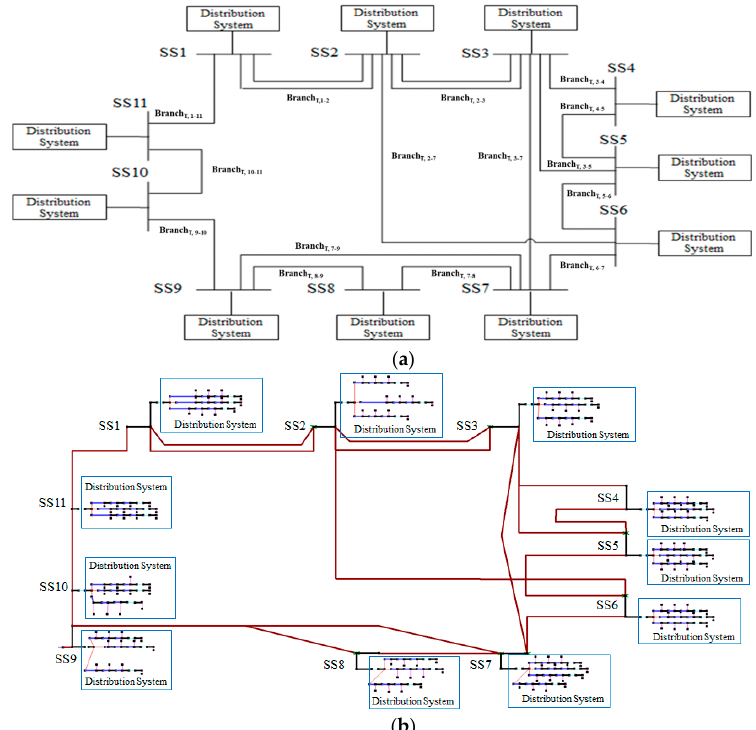
Figure 6. ( a ) Structure of the transmission system for simulation and ( b ) the transmission circuit in the DEW.